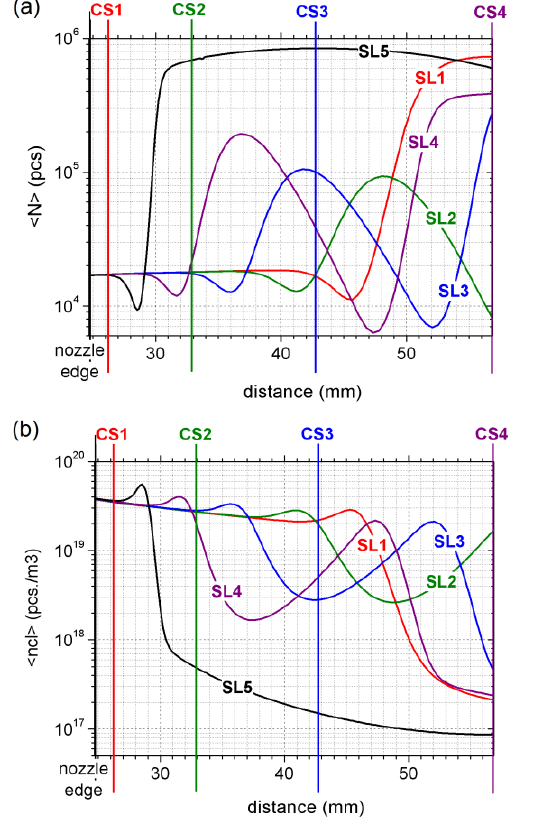
Fig. 2. Distributions of (a) mean cluster size < N > and (b) mean cluster concentration < n cl >, along five stream lines (SL1-SL5) as a function of the distance from the nozzle